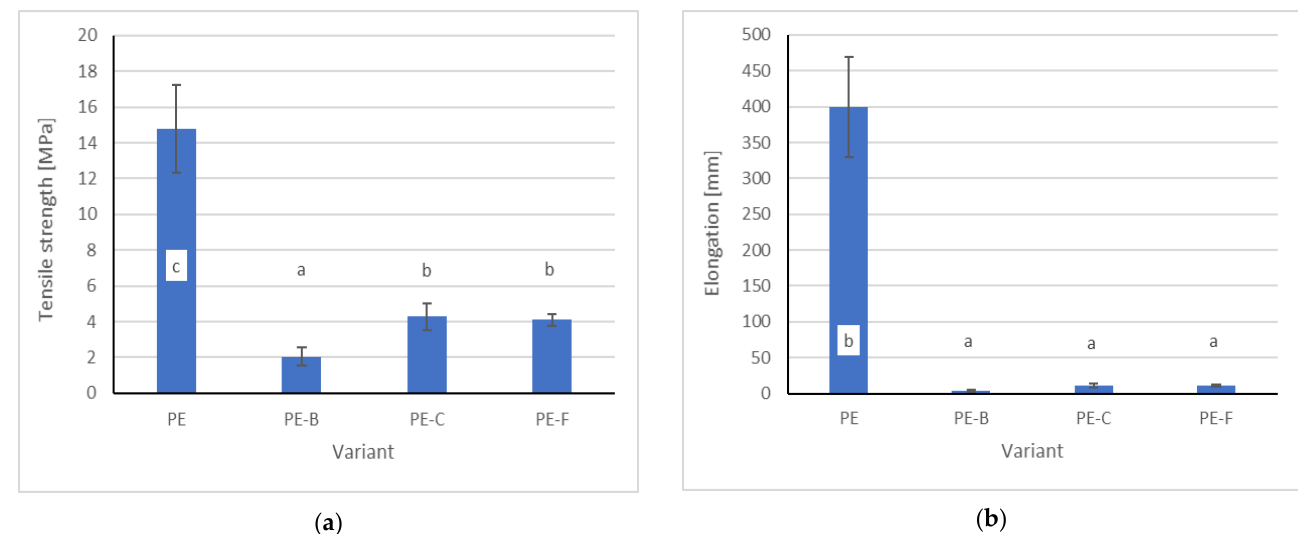
Figure 3. Mechanical properties of PE–pomace based membranes ( a ) tensile strength; ( b ) elongation; abc is the homogeneous groups by the Tukey test ( α = 0.05). Table 1. Measurement of maximum breaking load, Young’s modulus and thickness of PE – pomace based membranes.